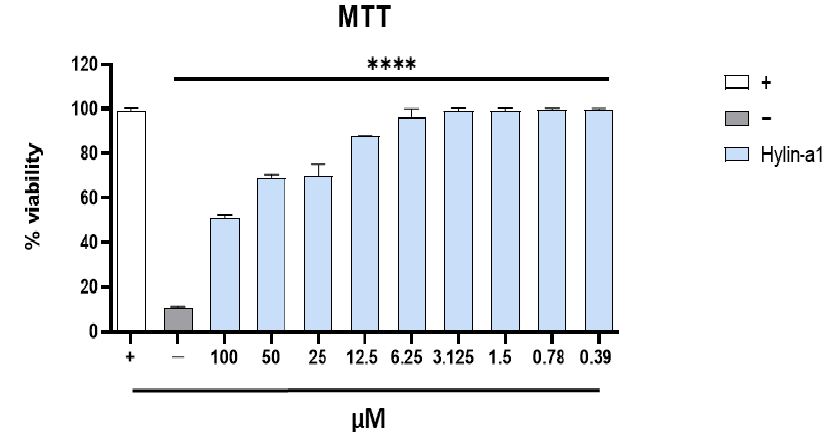
Figure 1. Evaluation of the toxicity of Hylin-a1 in HaCaT cells. Peptide toxicity was evaluated by the MTT assay after 20 h. Untreated cells were used as a positive control (+), while DMSO-treated cells were used as a negative control ( − ). **** p < 0.0001.